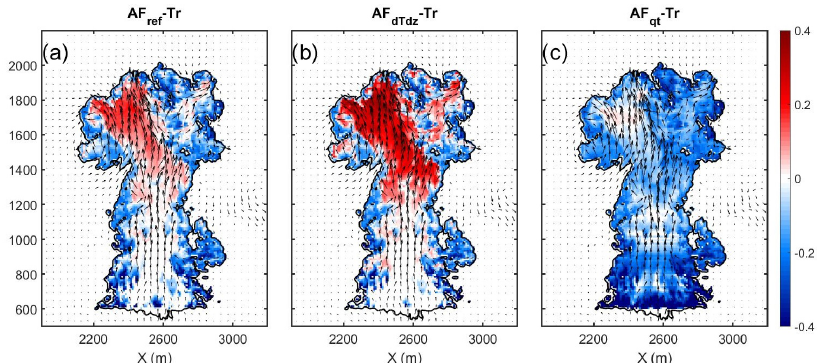
Figure 2. Vertical cross sections for the differences between various AF methods, using approximated profiles (Fig. 1e–g), and the tracer (Fig. 1d). (a) Difference between AF ref and Tr (Fig. 1e minus Fig. 1d). (b) Same as (a) for AF d t d z . (c) Same as (a) for AF qt